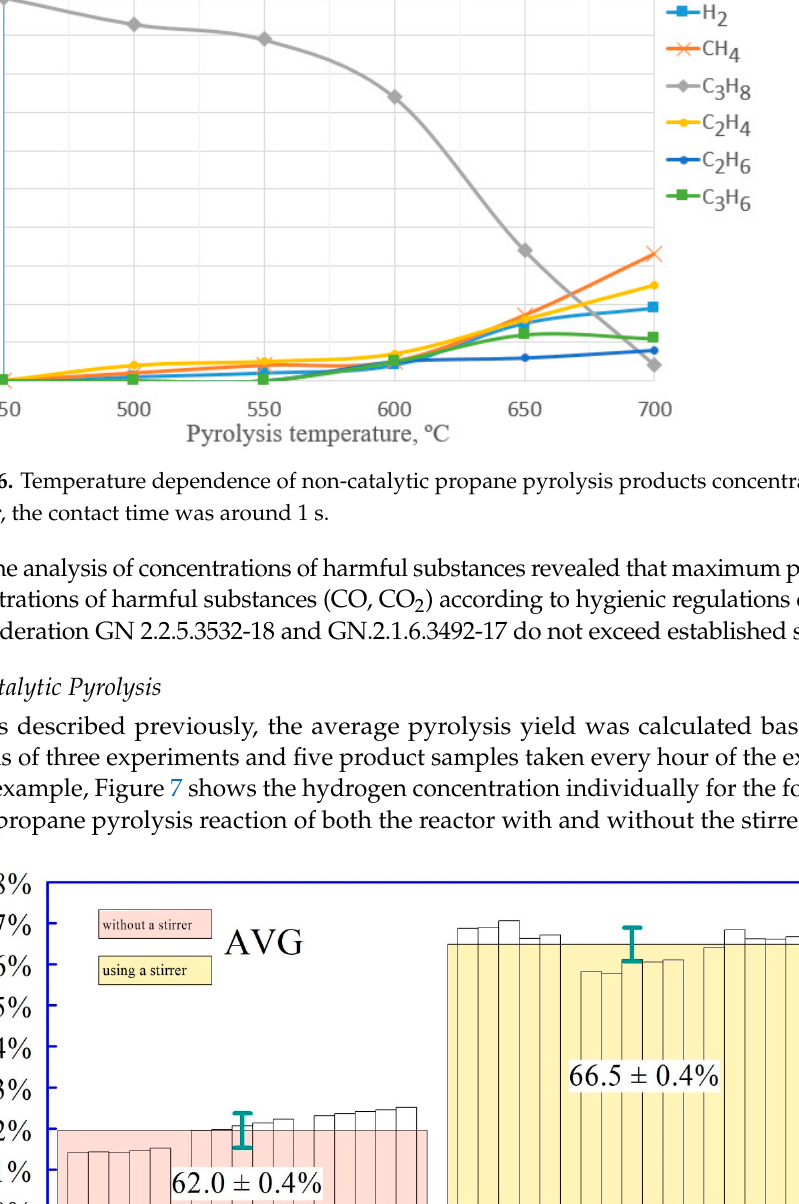
Figure 6. Temperature dependence of non-catalytic propane pyrolysis products concentration using a stirrer, the contact time was around 1 s.